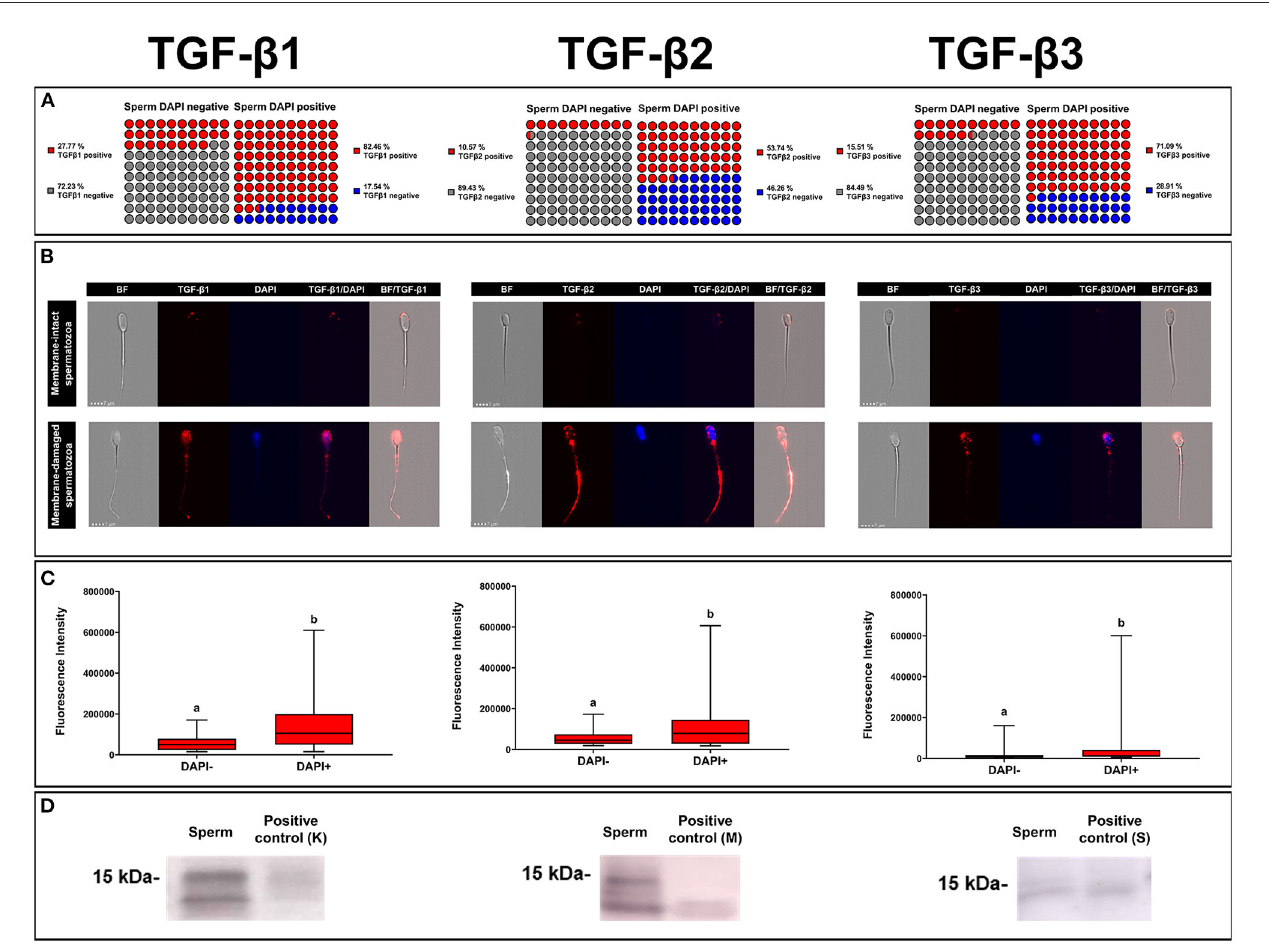
FIGURE6 Immunocytochemistry expression of TGF- β 1, - β 2, - β 3 in pig ejaculated spermatozoa. (A) Percentage of sperm expressing TGF- β 1, - β 2, and - β 3 in spermatozoa showing intact [4’,6-diamidino-2-fenilindol (DAPI) negative] or damaged (DAPI positive) membranes. (B) Representative images of TGF- β 1, - β 2, and - β 3 expression (red fluorescence) in spermatozoa with intact (DAPI negative) or damaged (blue fluorescence, DAPI) plasma membrane (bright field, BF). (C) Fluorescence intensity of TGF- β 1, - β 2, and - β 3 expression measured in arbitrary units. The plots show data from three biological replicates with more than 10,000 events analyzed per replicate. Boxes enclose the 25th and 75th percentiles, whiskers extend to the 5th and 95th percentiles and the line indicates the median. Different letters above the bars indicate significantly different values ( p < 0.001). (D) TGF- β 1, - β 2, and - β 3 expression of mature band ( ∼ 15 kDa) in sperm and positive controls [pig kidney (K) for TGF- β 1, human amniotic membrane (M) for TGF- β 2 and pig spleen tissue (S) for TGF- β 3].